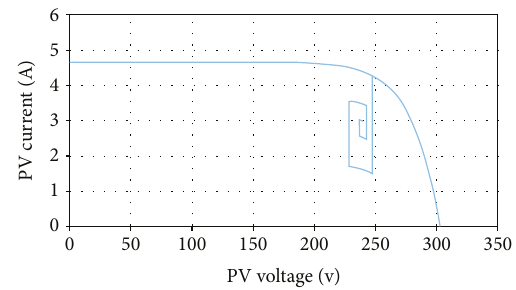
Figure 5: I-V curve with